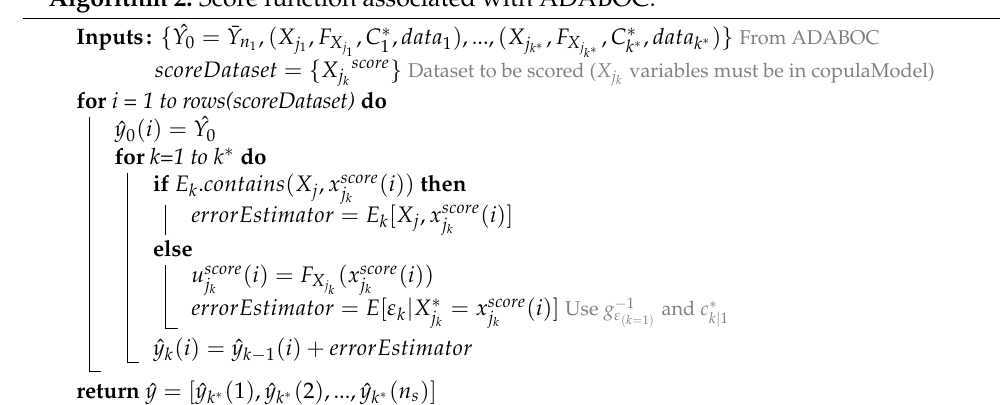
Algorithm 2: Score function associated with